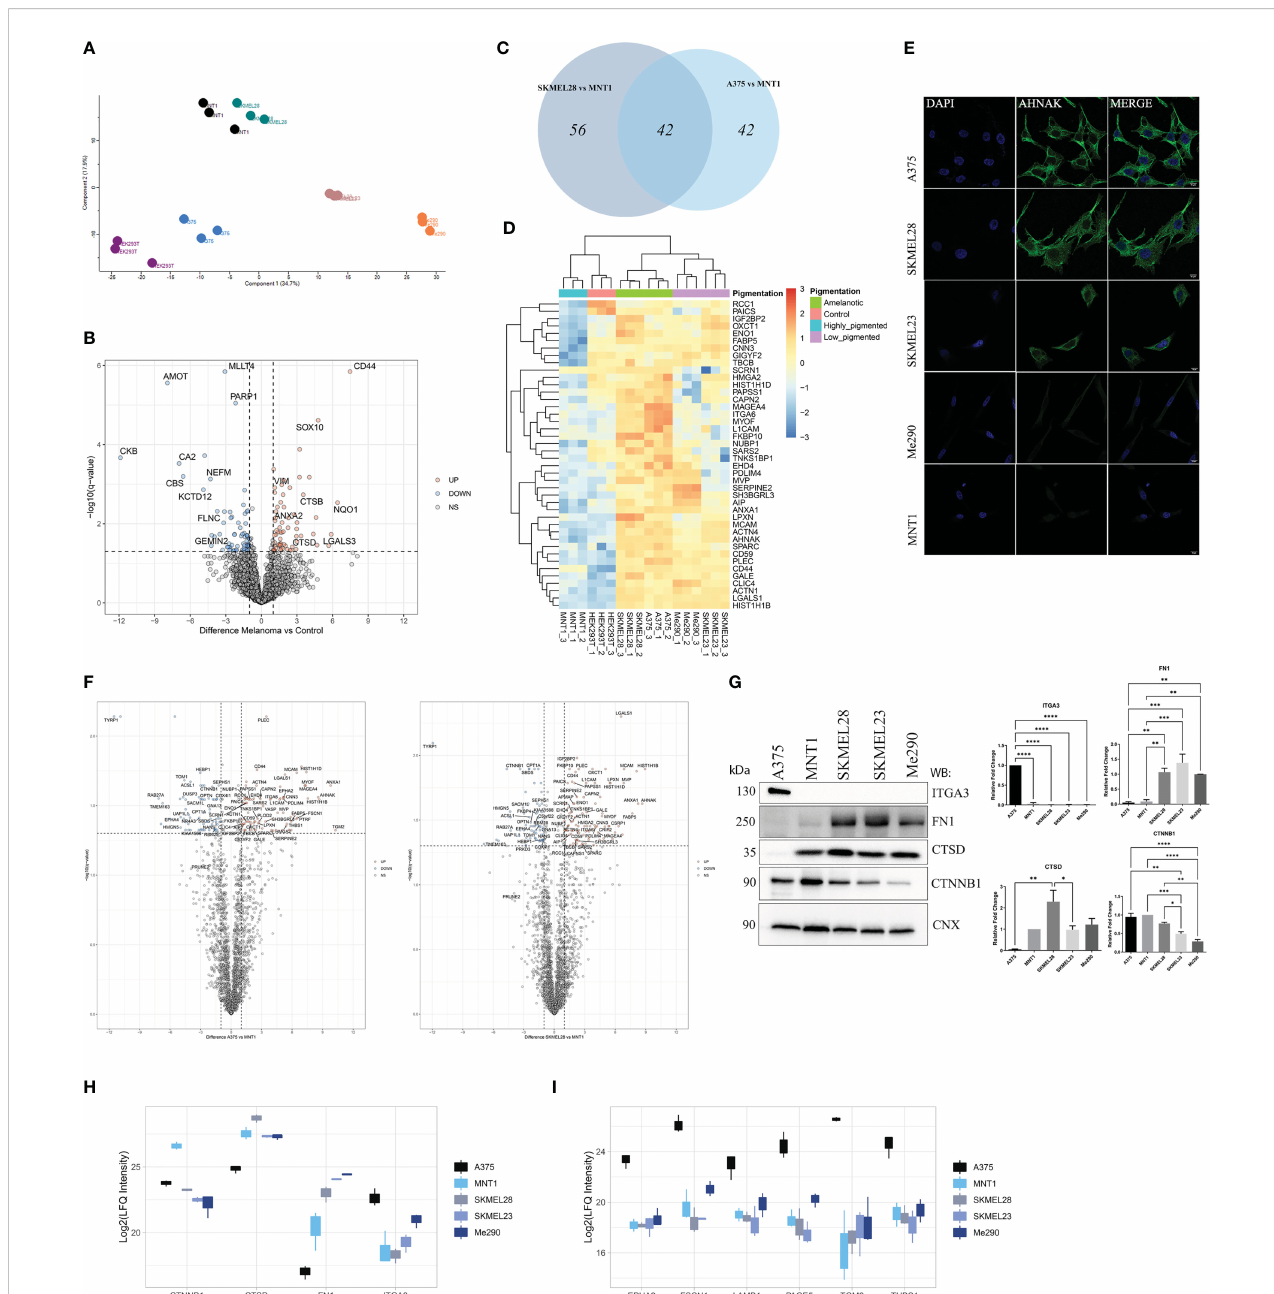
FIGURE 2 LC-MS/MS proteome comparison of amelanotic versus pigmented melanoma cells. (A) Principal Component Analysis (PCA) showing clustering of samples according to their features. (B) Volcano plot of protein expression differences (log2FC) vs -log10(q value) from two sample t test of melanoma samples vs control (q-value<0.05 and absolute log2FC ≥ 1) (Supplementary Table 1, S1). (C) Venn diagram depicting shared upregulated proteins from the pairwise comparisons between A375 vs MNT1 and SKMEL28 vs MNT1. (D) Heatmap of log2 transformed LFQ intensity values showing the statistically signi fi cant shared up-regulated proteins from the comparisons between amelanotic cell lines (A375 and SKMEL28) and highly pigmented MNT1 cells (pairwise comparisons, two sample t test, q-value<0.05 and log2FC ≥ 1) (Supplementary Table 1, S1). (E) Immuno fl uorescent staining of AHNAK in A375, SKMEL28, SKMEL23, Me290 and MNT1 cell lines. (F) Volcano plots highlighting differentially expressed proteins from the pairwise comparisons between amelanotic cells and highly pigmented MNT1 cells (q-value<0.05 and absolute log2FC ≥ 1) (Supplementary Table 1, S1). (G) Western blotting assays and intensity band quanti fi cation for ITGA3, FN1, CTSD and CTNNB1 protein levels (one-way ANOVA analysis; ***p <0.001; **p<0.01; *p<0.05, n=3). Calnexin (CNX) was used as internal control. Data are presented as mean ± SEM. (H) Box plot of log2 transformed LFQ intensity values of CTNNB1, CTSD, FN1 and ITGA3 (Supplementary Table 1, S1). (I) Box plot of log2 transformed LFQ intensity values for EPHA2, FSCN1, LAMB1, PAGE5, TGM2 and THBS1 (Supplementary Table 1,